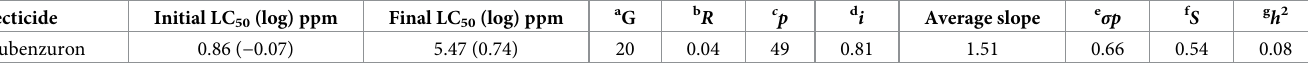
Bioassays were not performed at G 2 , G 3 , and G 4. a. Number of tested larvae in each bioassay. b.